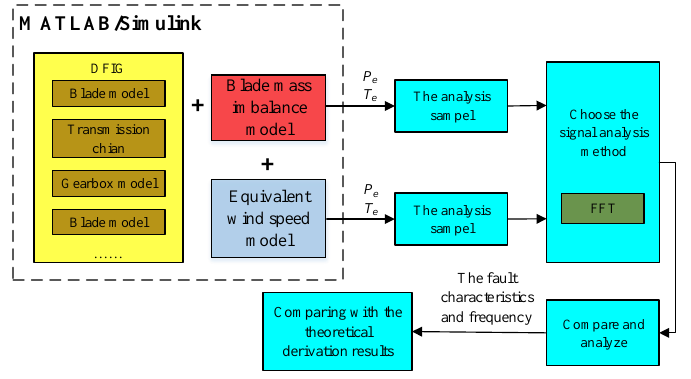
Figure 7. Flow diagram of fault diagnosis.